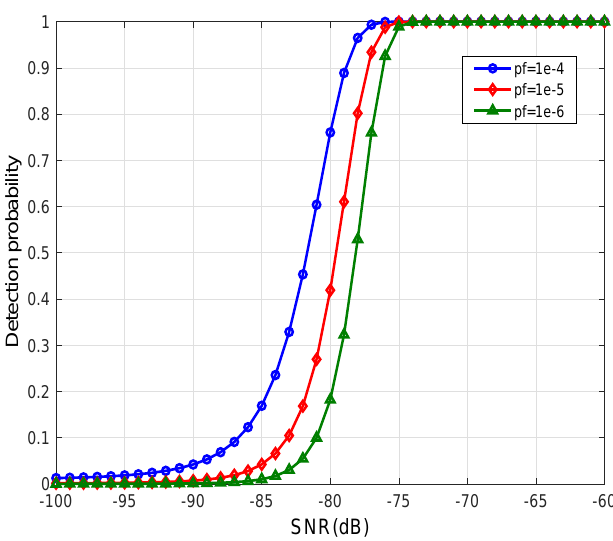
Figure 6. Detection performance with different false alarm